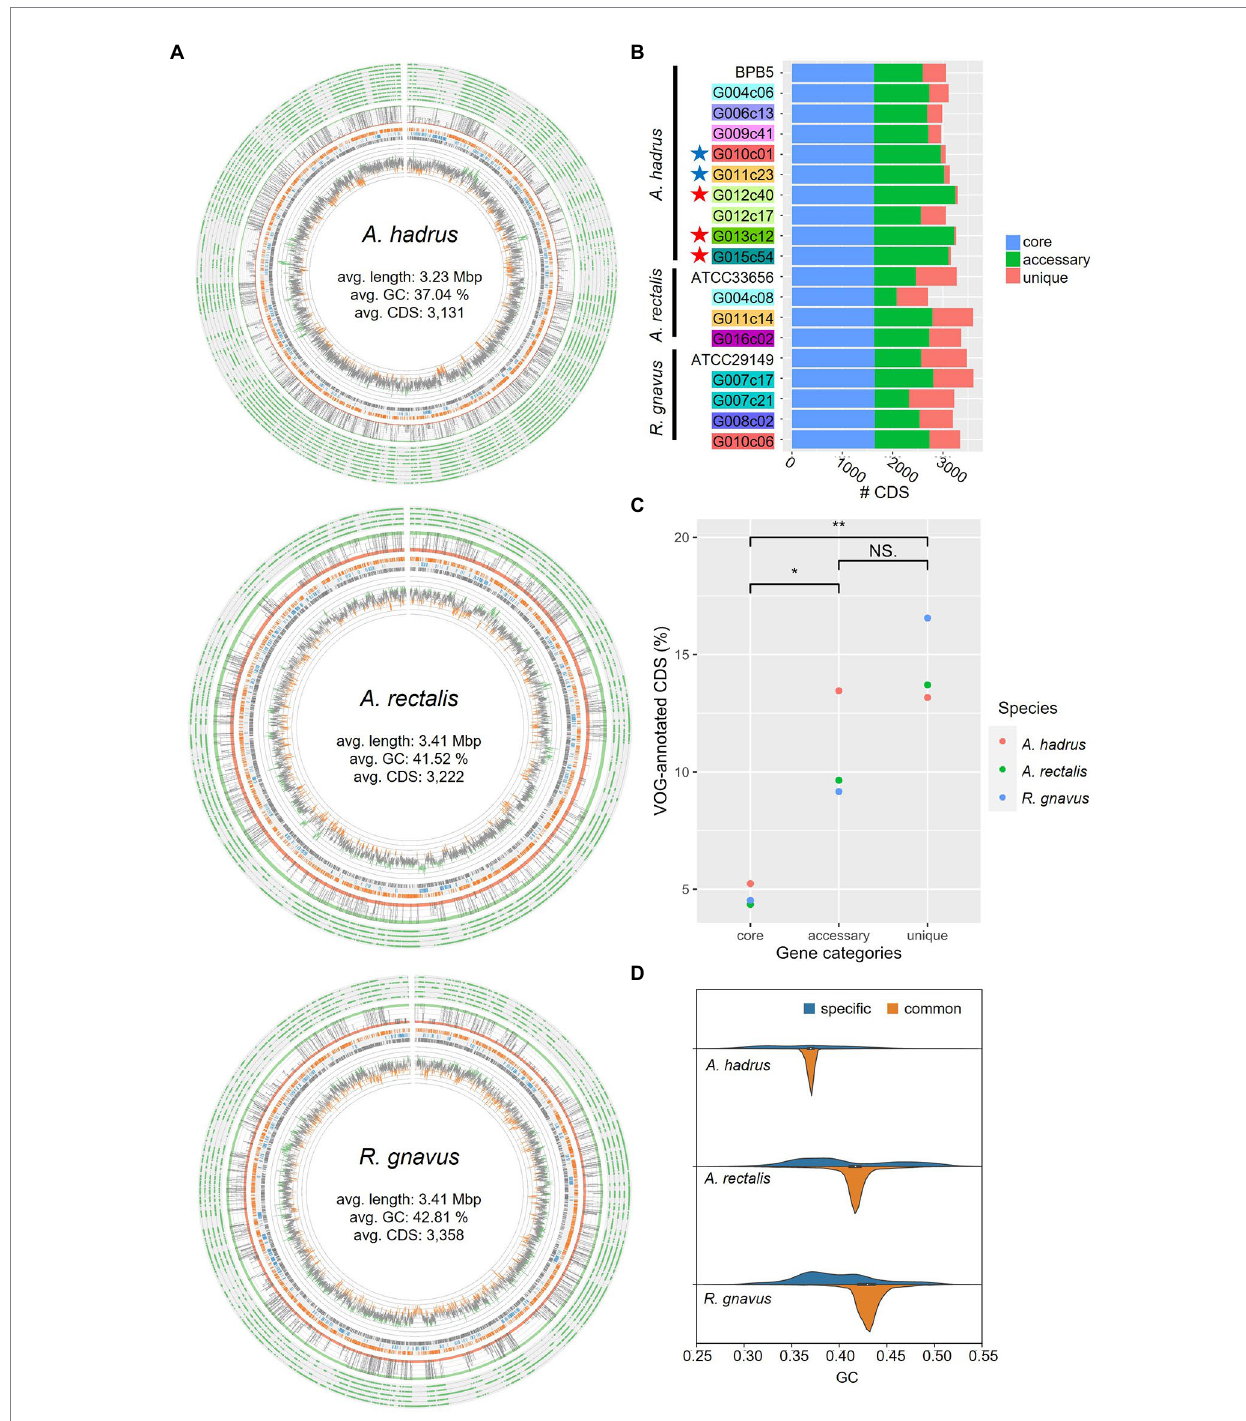
FIGURE 3 Comparison of the structures of gut bacterial circular single-amplified genomes (cSAGs). (A) Genome maps of A. hadrus , A. rectalis , and R. gnavus . Track 1 (outside) tiles indicate the presence (green) or absence of gene clusters in each strain genome. Track 2 is a line plot indicating the number of genomes, including the gene cluster (green ribbon: core gene, orange ribbon: unique gene). Track 3 plots the gene cluster annotations (orange: Kyoto Encyclopedia of Genes and Genomes (KEGG)-annotated clusters, blue: COG-annotated clusters, gray: unannotated clusters). Track 4 is a line plot of GC contents (green: high-GC region, orange: low-GC region). (B) Number of homologous gene clusters in cSAGs and reference genomes. The number of coding sequences (CDS) in core orthologous genes (OGs; blue), accessory OGs (green), and unique OGs (red) are shown per cSAG. Highlighted labels indicate the hosts, and colored stars indicate closely related genomes obtained from the cohabitants. (C) Accumulation of virus orthologous groups (VOG)-annotated CDS in the strain-specific accessory or unique categories. (D) GC content distributions of three bacterial genomes divided into strain-specific and strain-common sequence